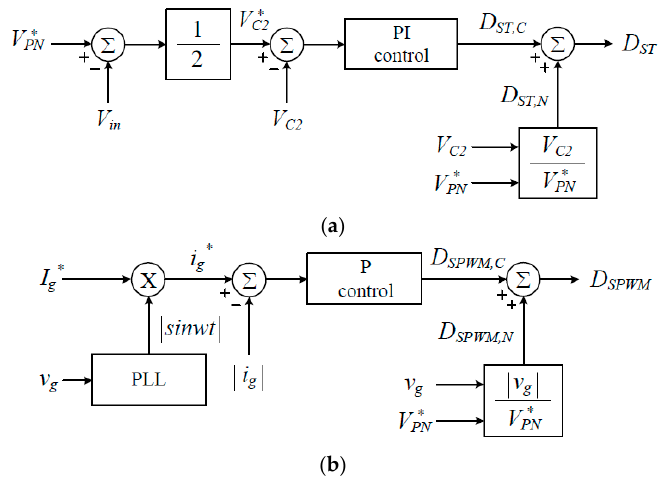
Figure 6. Control block diagrams of the proposed inverter: ( a ) DC-link voltage control; ( b ) grid current control.